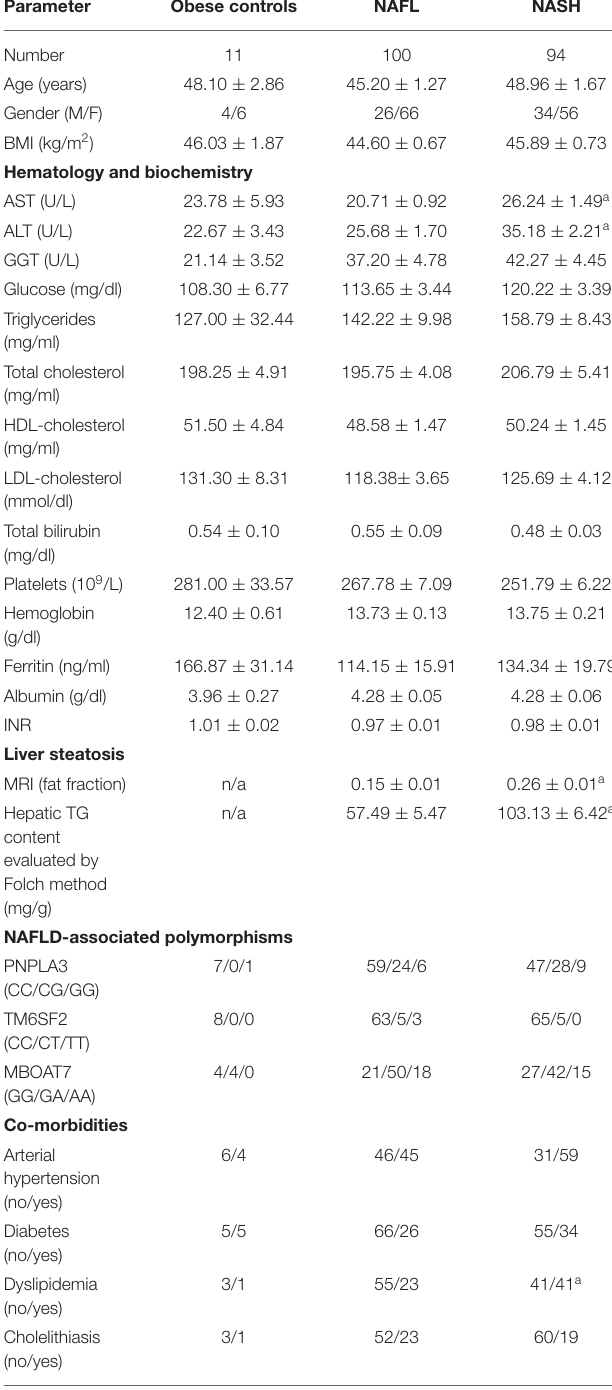
Data are expressed as mean ± SEM. Information not available for non-obese controls. ALT, alanine aminotransferase; AST, aspartate aminotransferase; BMI, body mass index; C, cytosine; F, female; G, guanine; GGT, γ -glutamyl transferase; HDL, high-density lipoprotein;INR,internationalnormalizedratio;LDL,low-densitylipoprotein;M,male;MRI, magnetic resonance imaging; n/a, not available; NAFL, nonalcoholic fatty liver; NASH, nonalcoholic steatohepatitis; T, thymine. a p < 0.05 vs.